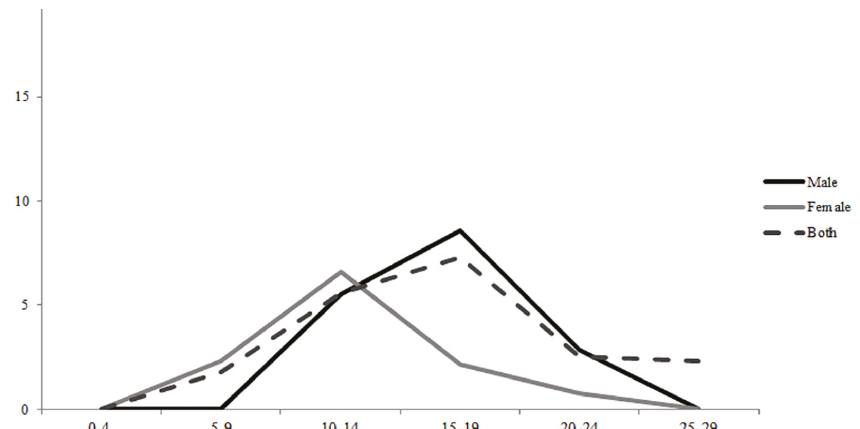
Figure 1 – Age-specific incidence rates (ASIR) of Osteosarcoma in children, adolescents and young adults in Brazil, according to gender and age group.